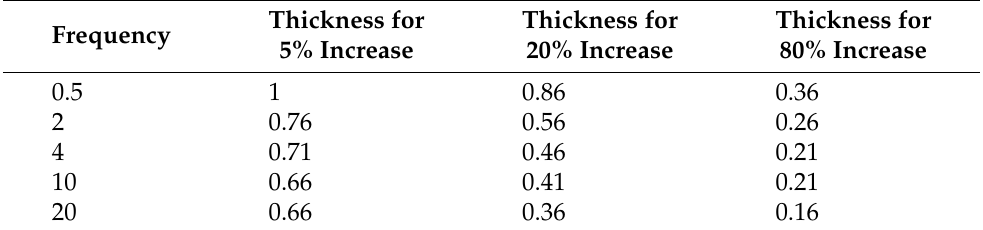
Table 4. Retrieved relative permittivity change of skin–olive oil double-layered configurations with 2.2 mm diameter probe at 0.5, 2, 4, 10 and 20 GHz frequency